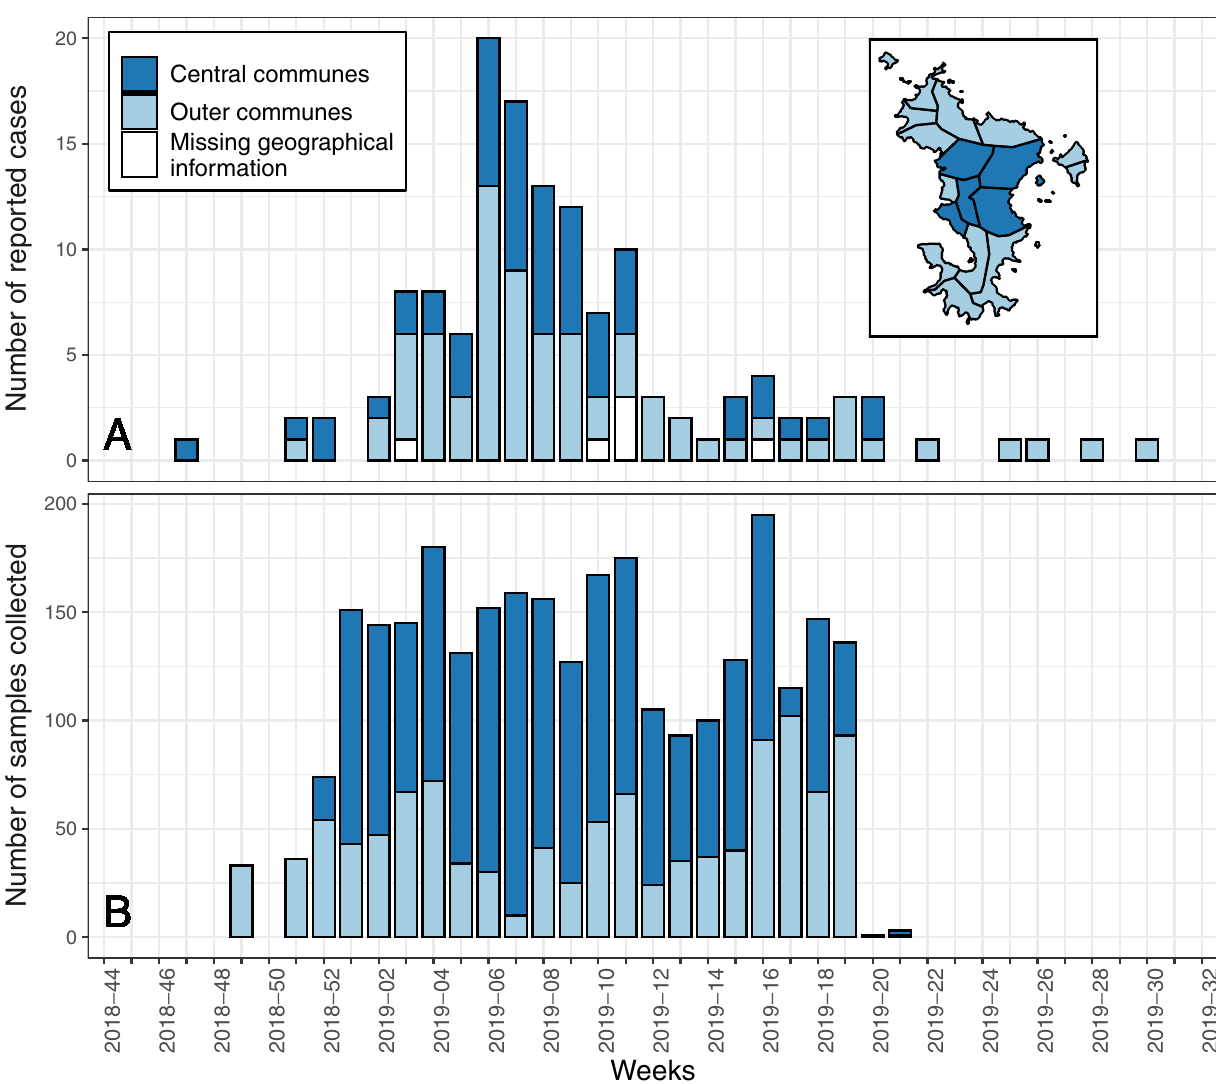
Fig. 1 RVF data collected between week 2018 – 47 (November 2018) and week 2019 – 30 (July 2019) in people aged over 15 years old. A Number of reported human cases by week from the surveillance system, and ( B ) number of blood samples collected by week as part of Unono Wa Maore survey. Light blue represents data collected from people living in the Outer communes of Mayotte Island, and dark blue in the Central communes, as depicted on the map at the top-right corner (see Supplementary Note 1 for details). For reported cases ( A ), we represent the week of symptoms onset or, if missing, the week of RT-PCR con fi rmation. For the seroprevalence study ( B ), we represent the week of sampling. Geographical information was missing for six reported cases aged over 15 years